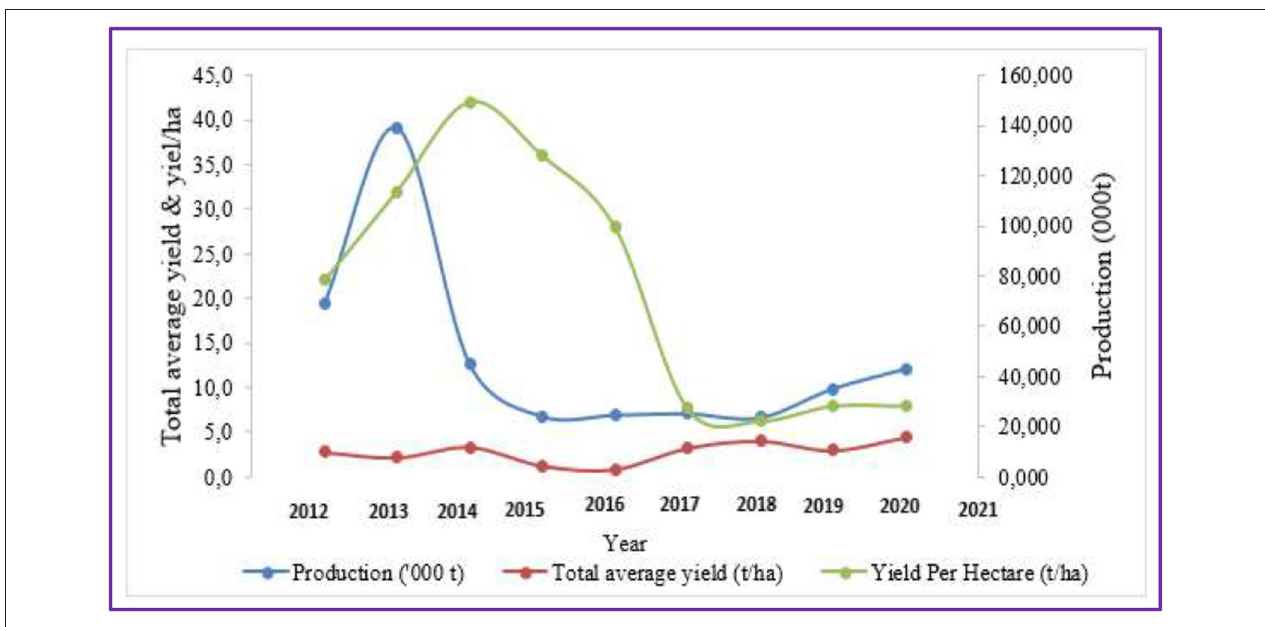
FIGURE 5 | Sorghum for year